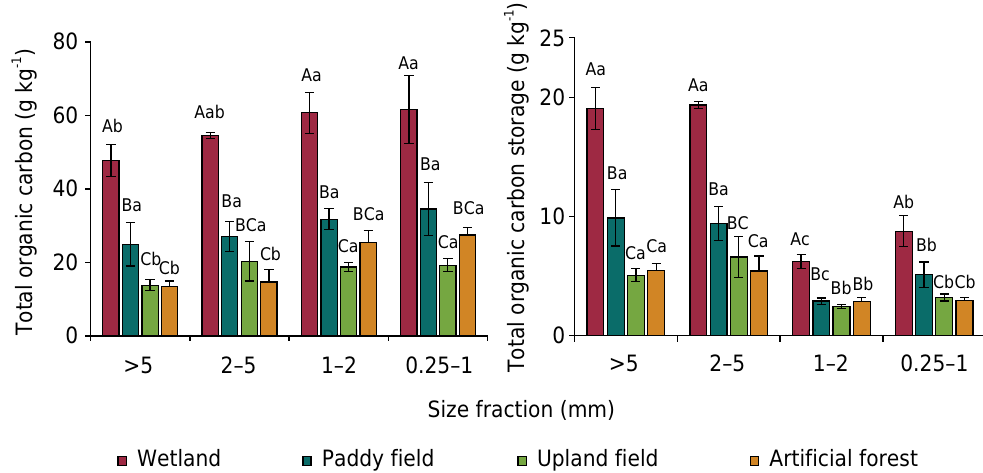
Figure 3. Content and storage of total organic carbon in soil aggregates from different land-uses in the Sanjiang Plain wetlands. Capital letters represent the differences between different land-uses at the same soil aggregates. Lowercase letters represent the differences of the same land-use in different soil aggregates.